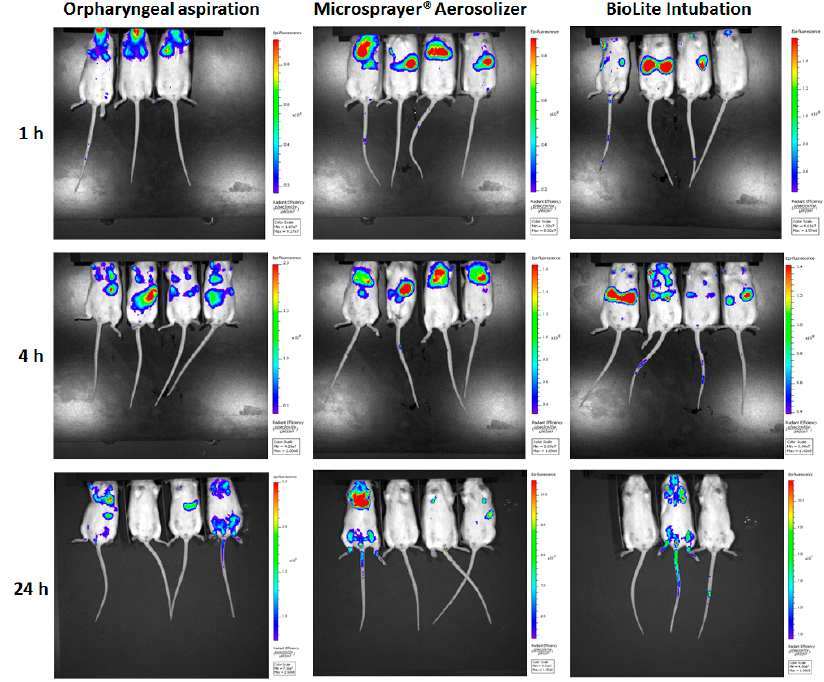
Figure 5. Whole animal images of mice acquired using IVIS Spectrum at 1, 4, and 24 h after pulmonary administration of near-infrared fluorescent Degradex ® poly( D , L -lactide-co-glycolide) (PLGA) microspheres using oropharyngeal aspiration, the MicroSprayer ® Aerosolizer, and the BioLite Intubation System.